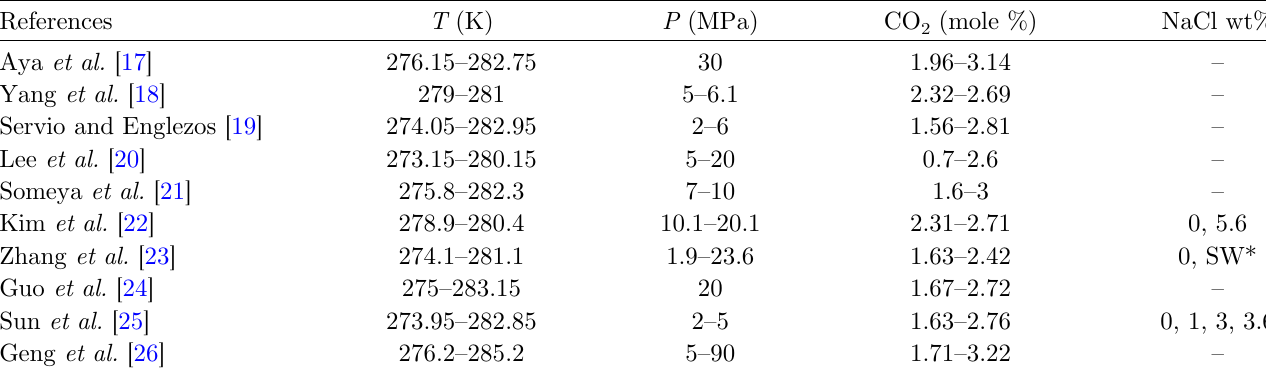
solubility in water and brines at hydrate – liquid water (HL 2